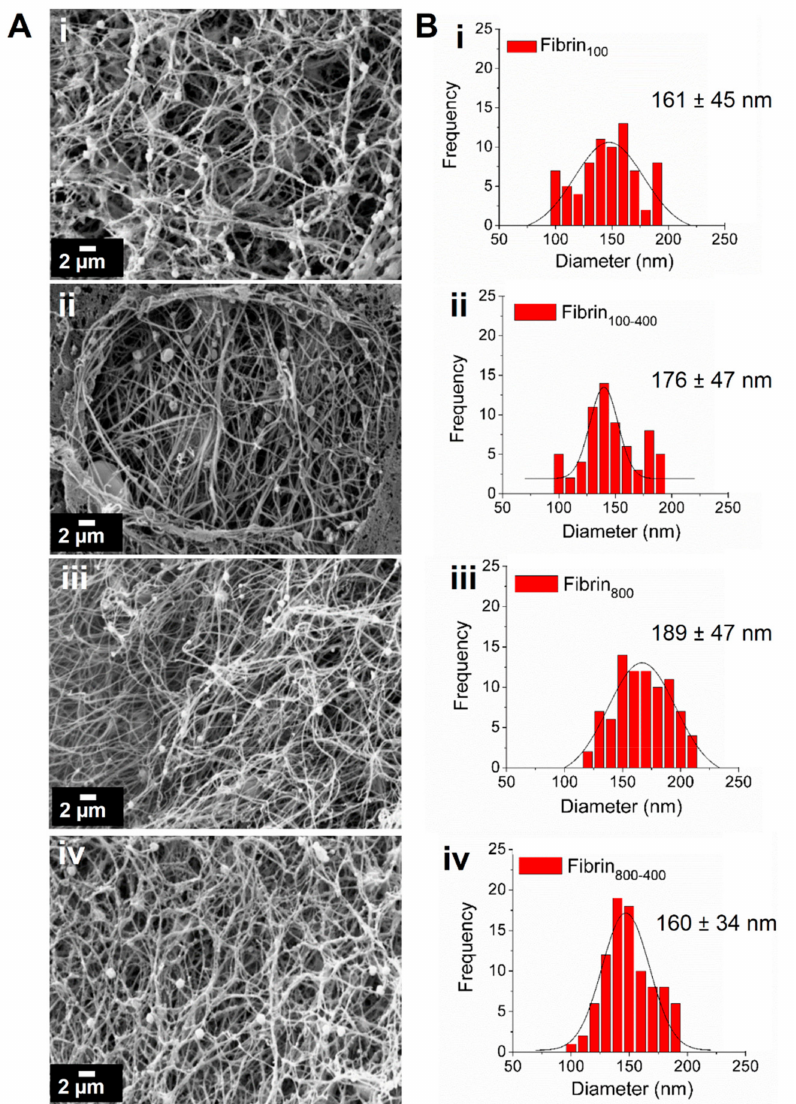
Figure 4. Characterization of the fibrin nanofibers. ( A ) SEM images showing the morphology of the networks. ( B ) Frequency of fiber diameter measured using ImageJ software, highlighting their mean diameter; ( i ) fibrin 100 , ( ii ) fibrin 100-400 , ( iii ) fibrin 800 , and ( iv ) fibrin 800-400